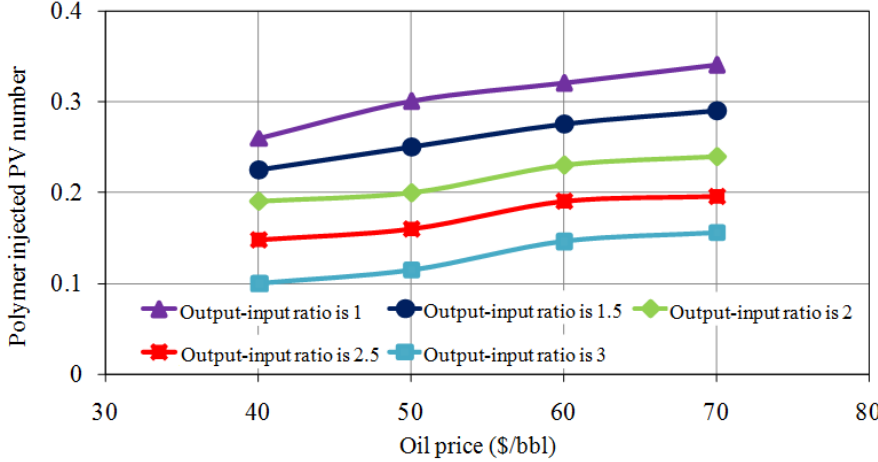
Figure 16. Depravation time of water/polymer flooding.